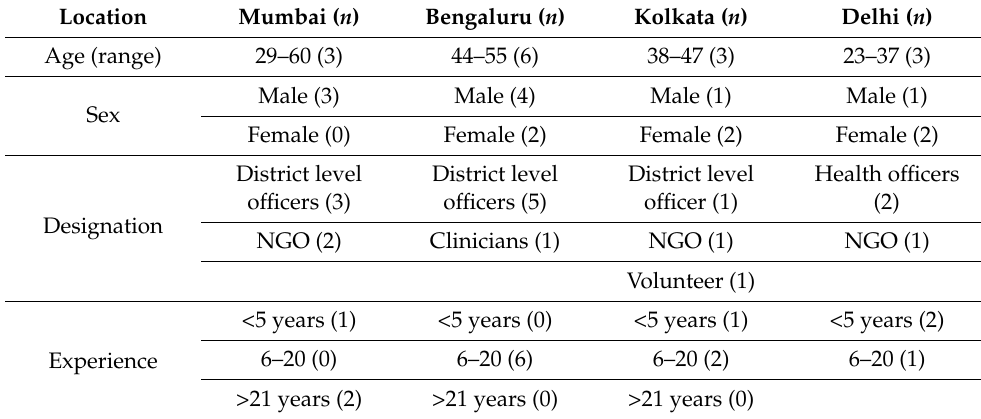
Table 4. Key-informant interview participants profile from Mumbai, Bengaluru, Kolkata and Delhi.